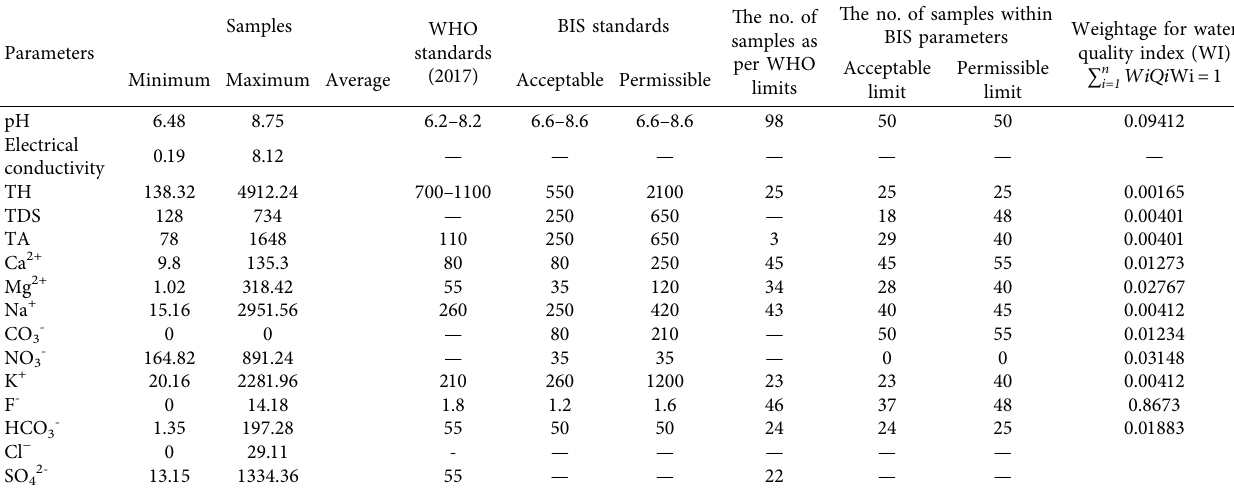
Table 1: Drinking water standard for ground water hydro-chemical